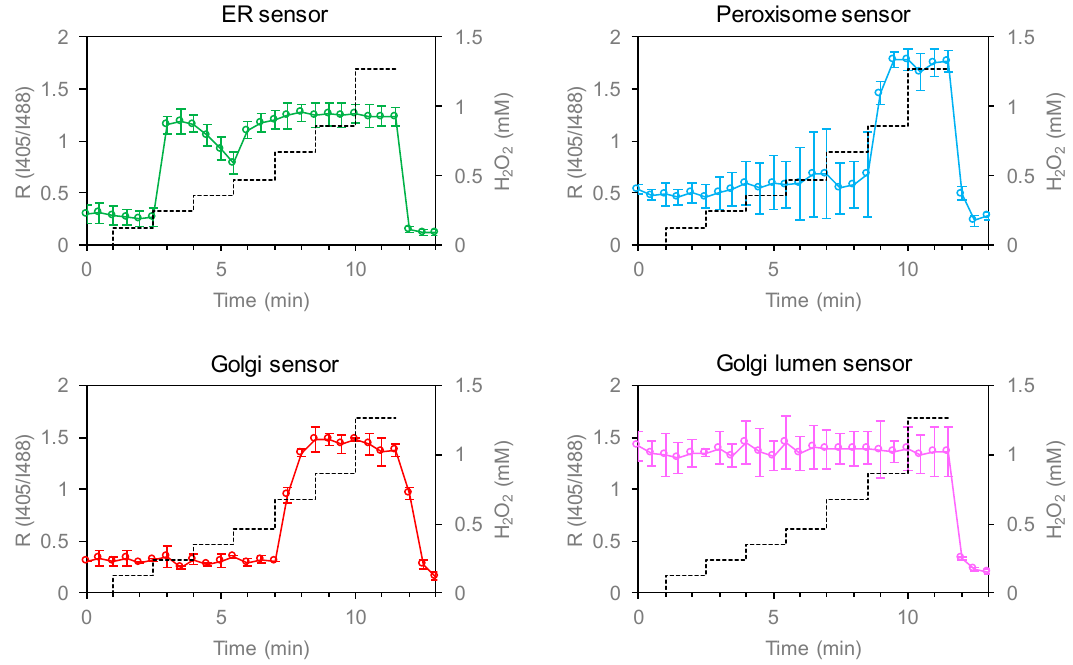
Figure 4. Validation of redox reactivity of constructed sensors in HeLa cells. Redox reactivity was tested by H 2 O 2 titration. I405 and I488 images were taken by confocal microscopy and the ratio R I405/I488 was obtained for each cell present within the observed area (typically n > 5). Dashed lines indicate concentrations of H 2 O 2 . Sensor oxidation was reversed by adding 5 mM dithiothreitol (DTT) at time point of 10.5 min.